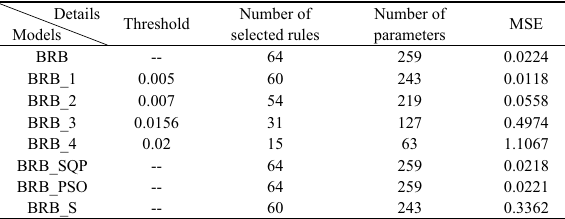
Table 6. The details and final testing results generated by different BRBs.